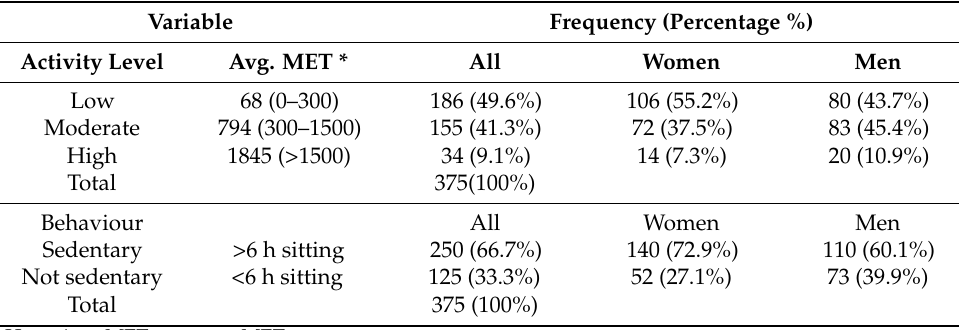
Table 4. Physical activity levels and sedentary lifestyles in university